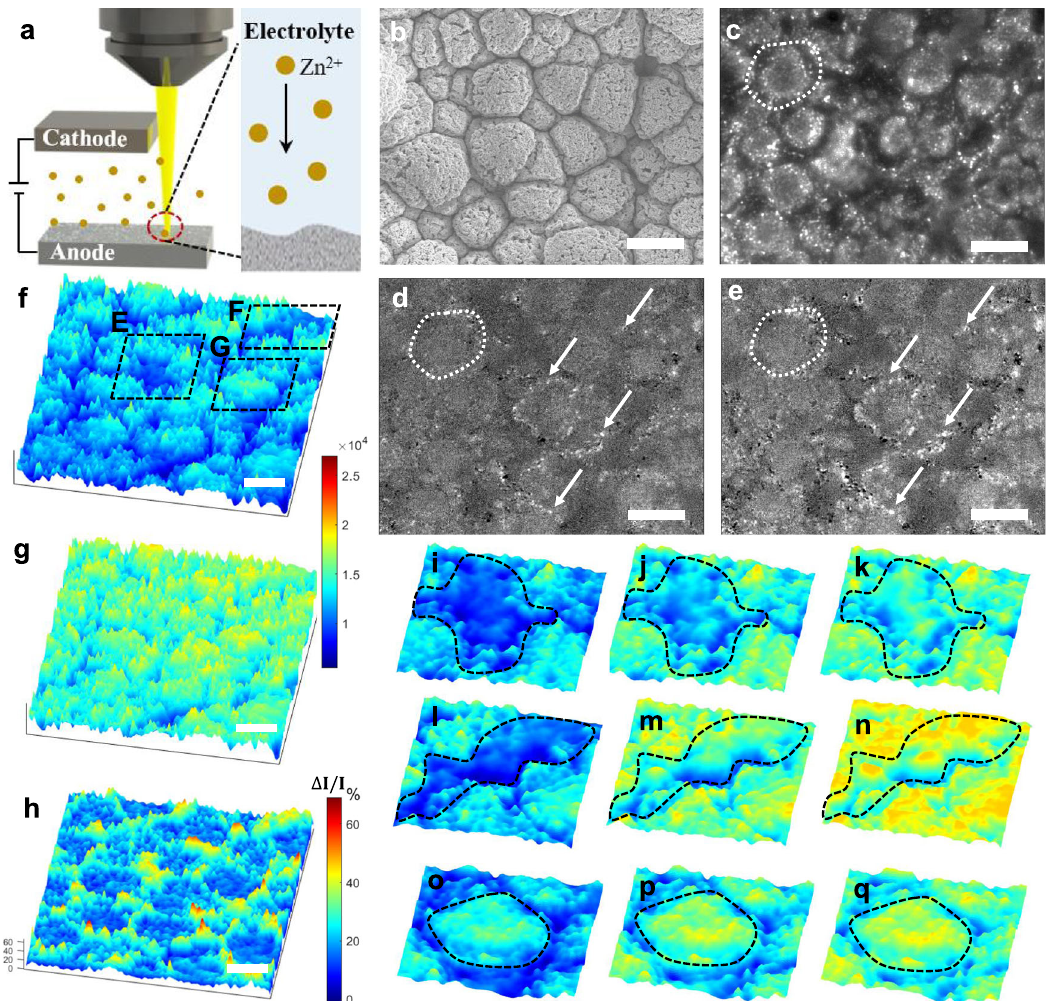
Fig. 3 Zn plating dynamics on 3D Zn-Mn alloy imaged by in-situ optical microscope. a Schematic illustration of the experimental setup. b SEM image of 3D Zn-Mn alloy. c – e The early stage of Zn plating. Images were taken with a ×20 water immersion objective at 25 frames per second, and the experiment was performed at a current density of 80 mA cm − 2 . c shows the 3D Zn-Mn alloy before the experiment. d , e show the differential images at 10 s and 30 s, respectively, after the start of the experiment. f – h Zn plating on 3D Zn-Mn alloy. The experiment was performed at a current density of 80 mA cm − 2 for 320 s. f , g are the images of 3D Zn-Mn alloy before and after Zn plating. h was calculated by ( g – f )/ f = ( Δ I / I ). i – q Evolution of Zn plating on the 3D Zn - Mn alloy. i – q are from the three different regions of interest labeled in f , where i – k , l – n , and o – q correspond to regions E , F , and G in f , respectively. The images were taken at 0 s ( i , l , o ), 160 s ( j , m , p ), and 320 s ( k , n , q ). The black dashed lines in ( i – q ) circle out the trench regions ( i – n ) and the protruding regions ( o – q ). Scale bars: 10 μ